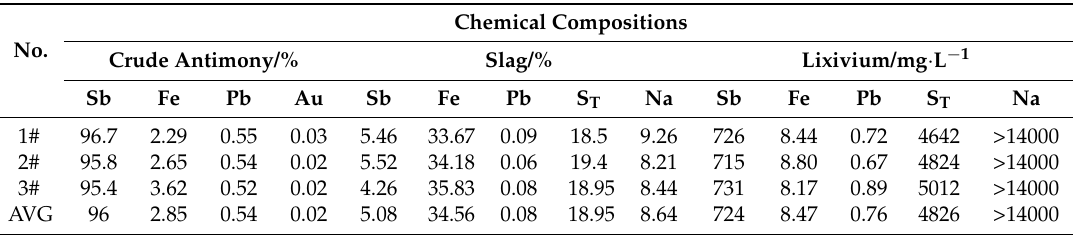
Figure 11. XRD analysis of molten slag and its residue after leaching. ( a ) molten slag; ( b ) residue.